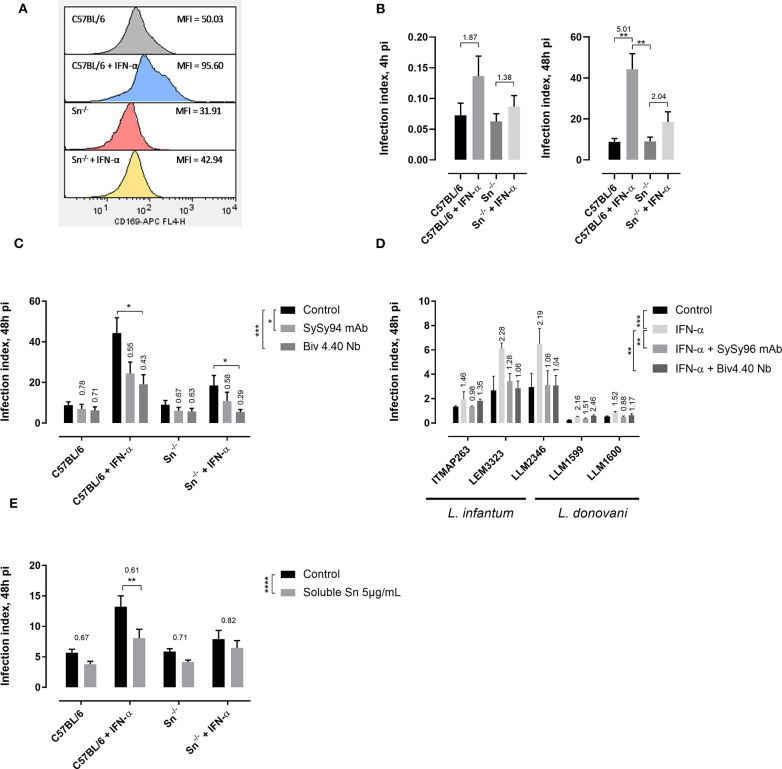
Upregulation of Sn expression by type I interferon enhances Leishmania uptake and intracellular multiplication. (A) Bone marrow-derived macrophages from C57BL/6 and Sn−/− mice were cultivated for 6 days with or without a 2-day stimulation with 5 × 102 IU/mL IFN-α. Sn surface expression was analyzed by flow cytometry and presented as histograms with the median fluorescence intensity (MFI). These are results from two independent repeats. (B) Infection index of LEM3323 promastigote infection (infection ratio 5:1) at 4 and 48 h post-infection in bone marrow-derived macrophages from C57BL/6 and Sn−/− mice either or not pre-stimulated with IFN-α. Results are based on two independent repeats, performed in quadruplicate. The ratio of IFN-α/control is stated above the bars. (C,D) Effect of anti-Sn monoclonal antibody SySy94 and anti-Sn Biv4.40 nanobody blocking at a concentration of 10 μg/mL of bone marrow-derived macrophages 1 h prior to infection with (C) LEM3323 (infection ratio 5:1) in C57BL/6 mice or (D) different L. infantum and L. donovani strains in BALB/c mice. Results are based on two independent repeats run in triplicate. The ratio of treatment/control is stated above the bars. (E) Parasites were incubated with soluble Sn at 5 μg/mL 1 h prior to infection of bone marrow cells. Results were obtained from two independent repeats run in quadruplicate. The ratio of treatment/control is stated above the bars. All results are expressed as mean ± standard error of mean (SEM) (*p < 0.05; **p < 0.01; ***p < 0.001; ****p < 0.0001).